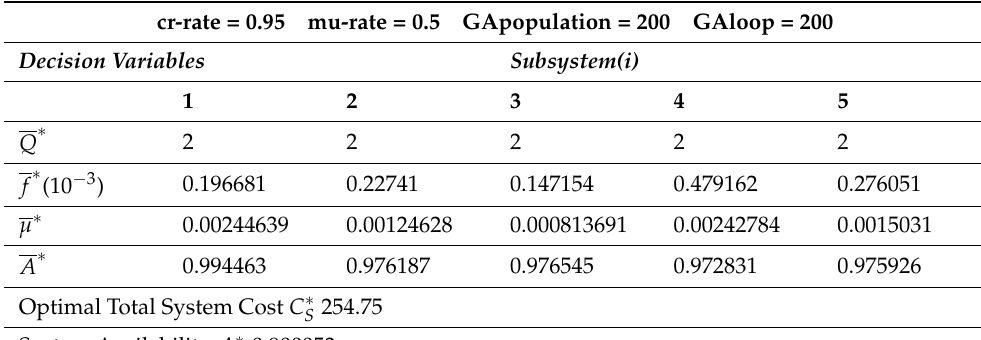
Table 26. Optimal Solutions obtained by ENUM–MGA for the n -stage q /2-out-of- q